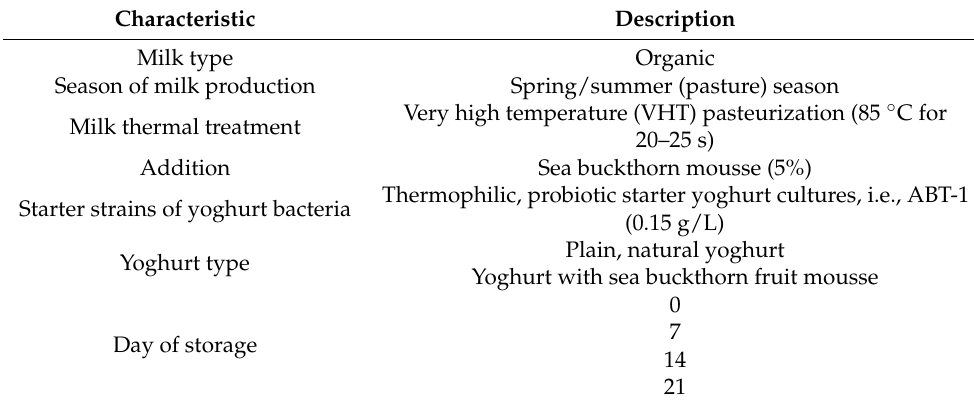
Table 1. The description of yoghurt